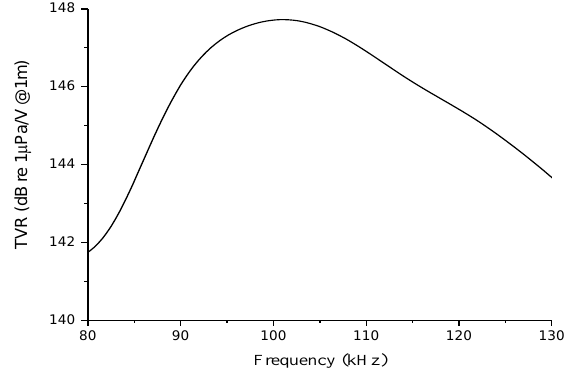
Figure 10. TVR spectrum of the 5 × 55 conformal array.